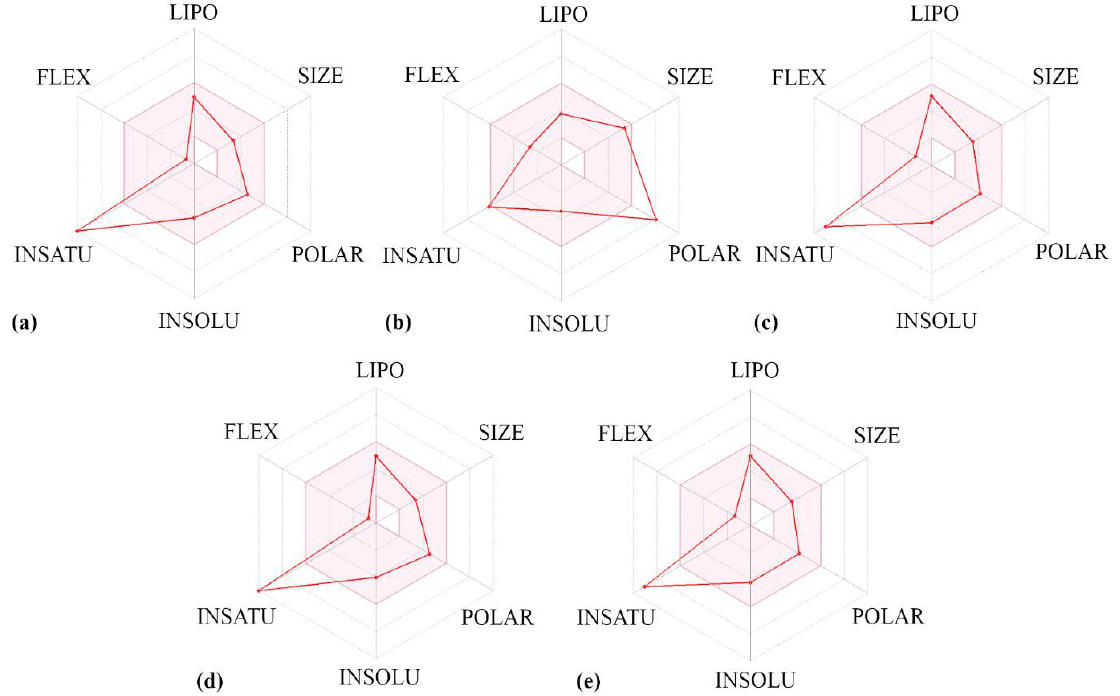
Figure 2. The bioavailability radar of baicalein ( a ), baicalin ( b ), wogonin ( c ), norwogonin ( d ), and oroxylin A ( e ) predicted using SwissADME Table 4. Predicted ADME-Tox features of baicalein, baicalin, wogonin, norwogonin, and oroxylin A. Their probability of exhibiting toxicity features is mentioned in brackets.